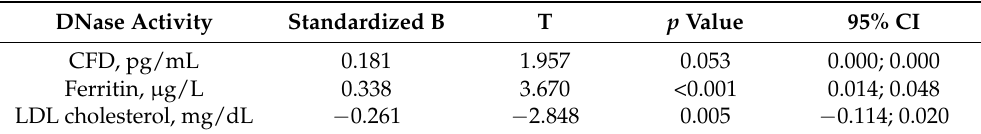
Table 3. Backwards multiple linear regression analysis of DNase activity at baseline.